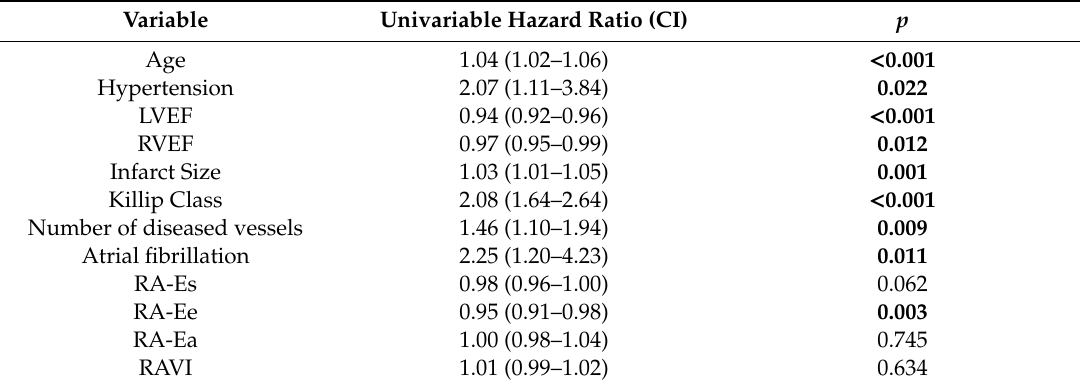
Table 4. Predictors of MACE in univariable Cox regression analysis.